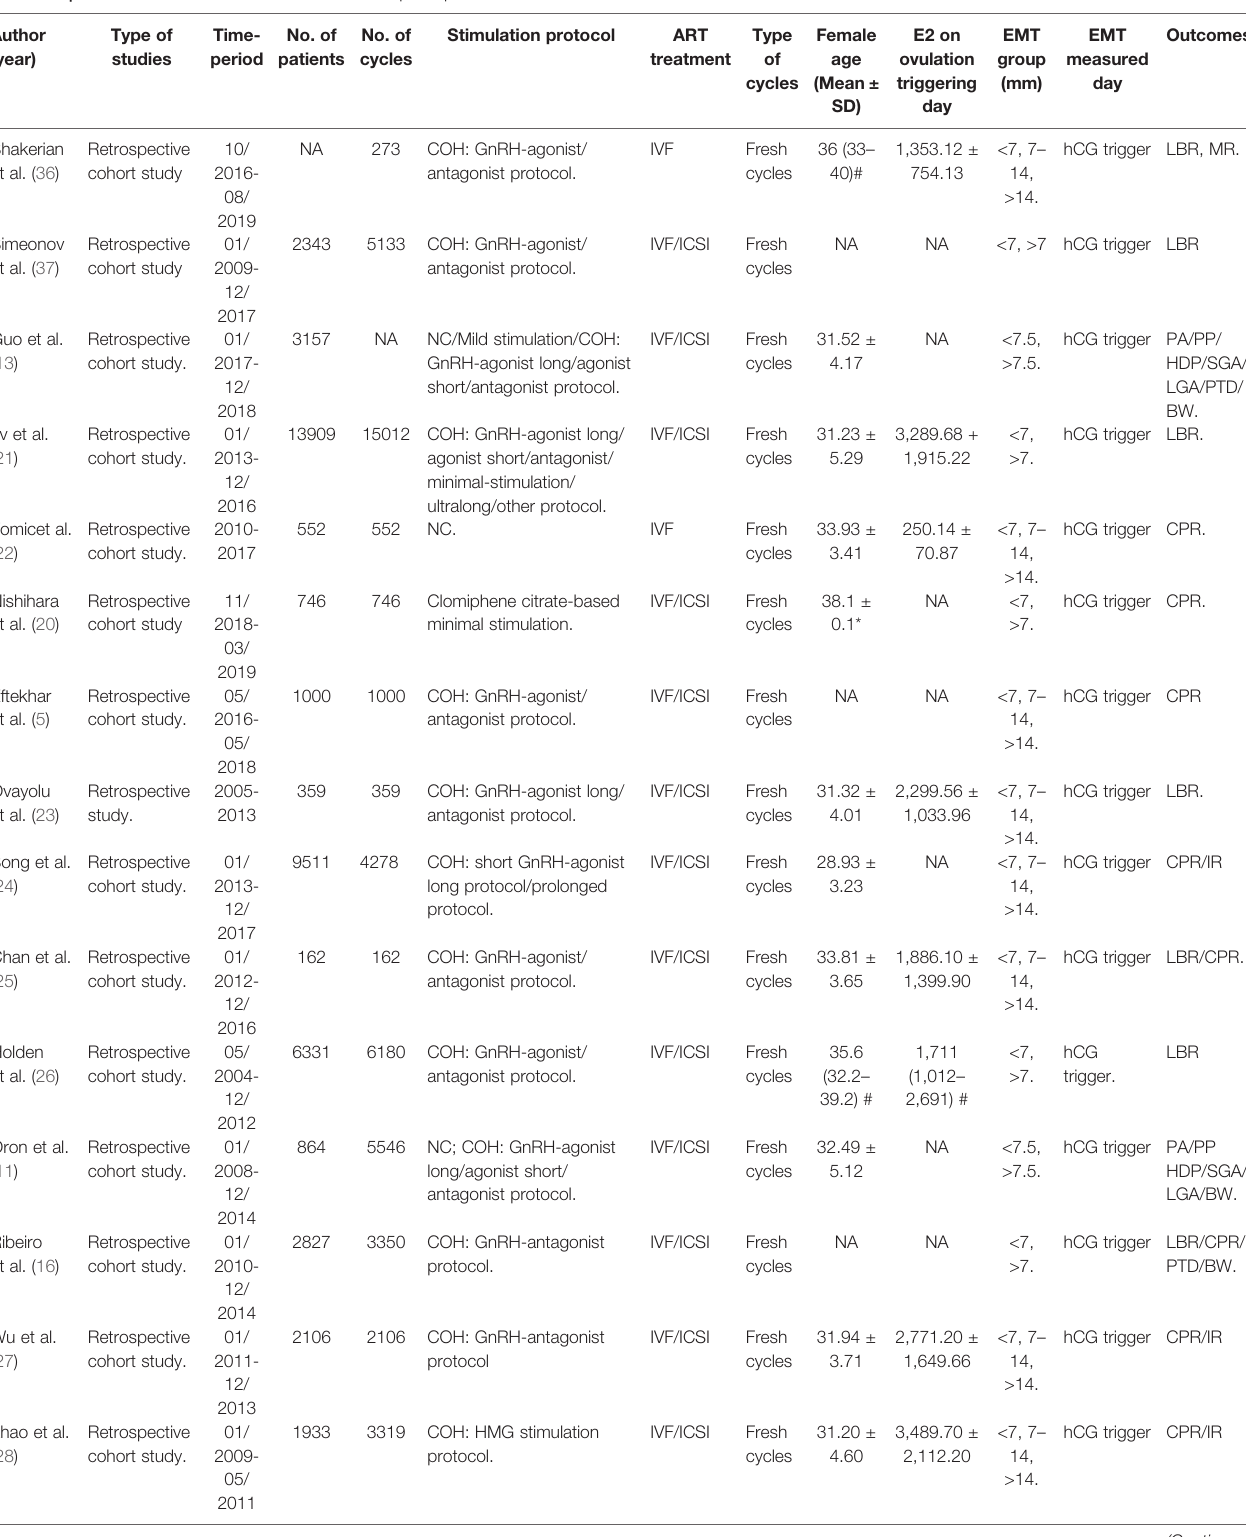
TABLE 1 | Characteristics of included references and